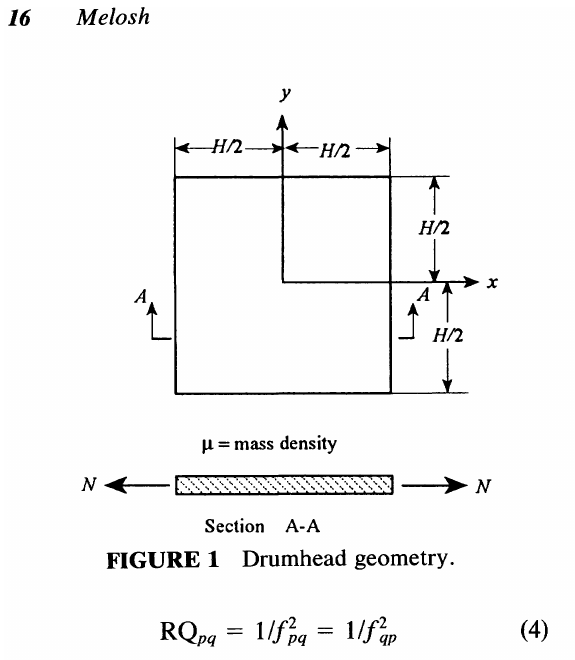
FIGURE 1 Drumhead geometry.